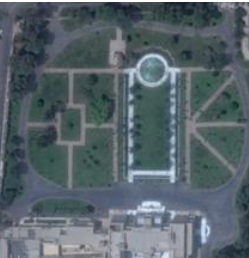
Figure 1. An example in the RSICD data set. An image is shown on the left and its corresponding descriptions are on the